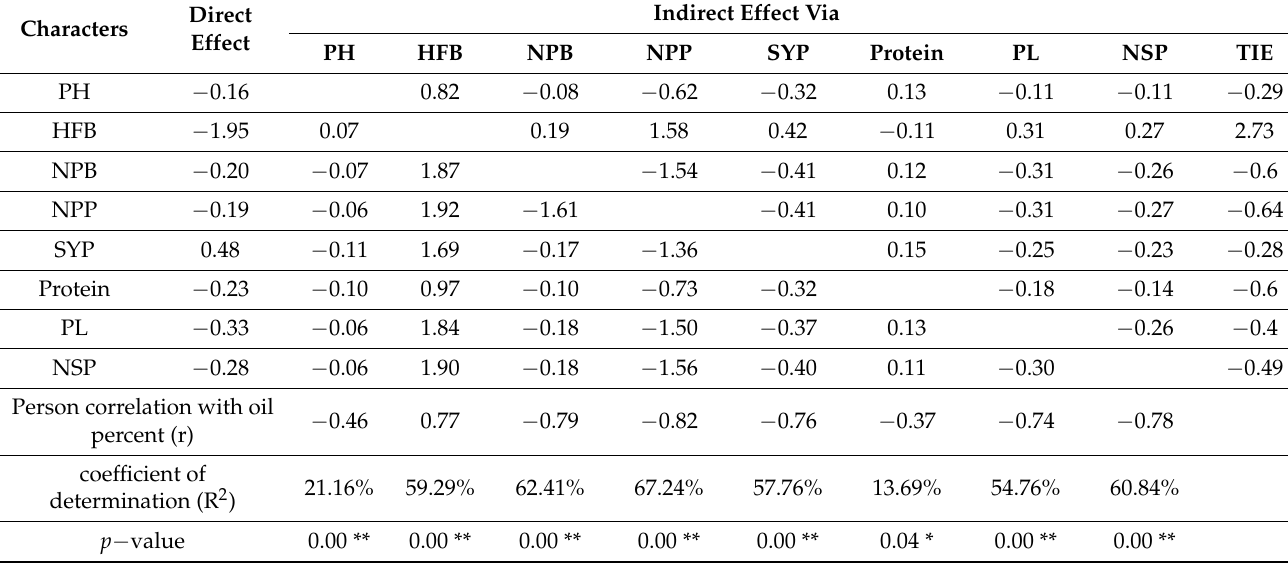
Figure 1. The path analysis for direct and indirect effects and Pearson correlation (r) of plant height (PH), number of primary branches (NPB), pods length (PL) and number of pods/plant (NPP) on seed yield/plant (SYP). ‘*’ means significant at p ≤ 0.05 and ‘**’ means significant at p ≤ 0.01. Table 3. Direct and indirect effects, pearson correlation and coefficient of determination (R 2 ) of different agronomic traits and quality characteristics on oil content (%) of five genotypes of Brassica